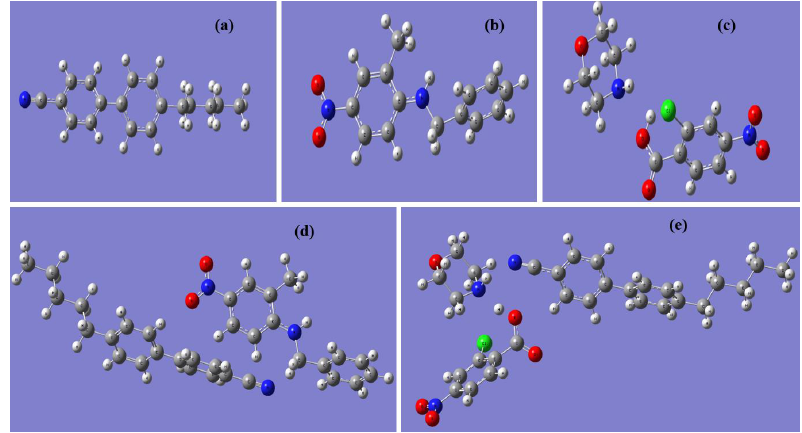
Figure 2. Optimized geometries for ( a ) 5CB, ( b ) BNA, ( c ) M2C4N, ( d ) 5CB + BNA, and ( e ) 5CB + M2C4N by Density Functional Theory (DFT).